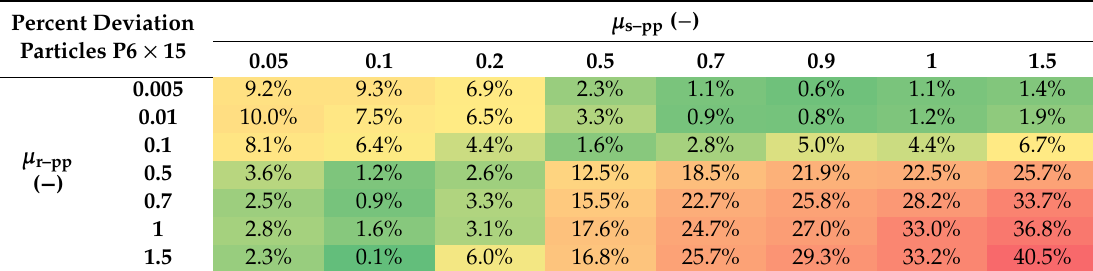
Table 6. The first estimation of frictional parameters via packing test for P6 × 15